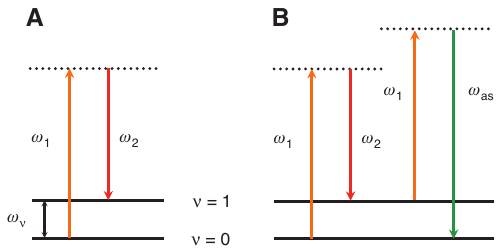
Figure 8: Jablonski diagrams of the SRS and CARS processes. (A) SRS. (B) CARS. The upward pointing arrow indicates the annihilation of a photon, while the downward arrow denotes the creation of a photon. SRS is a two-photon process, in which ω detection mode and the SRG detects the gain in the ω mode. The CARS is a four-photon process, in which two ω emitted. The CARS can detect the changes in the ω